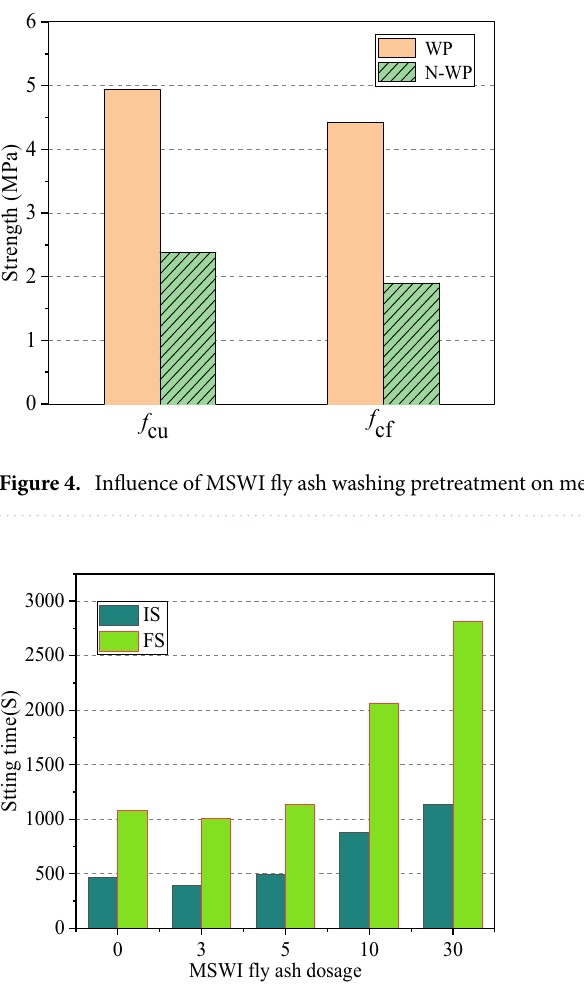
Figure 5. Influence of MSWI fly ash dosage on setting time of NBFM.